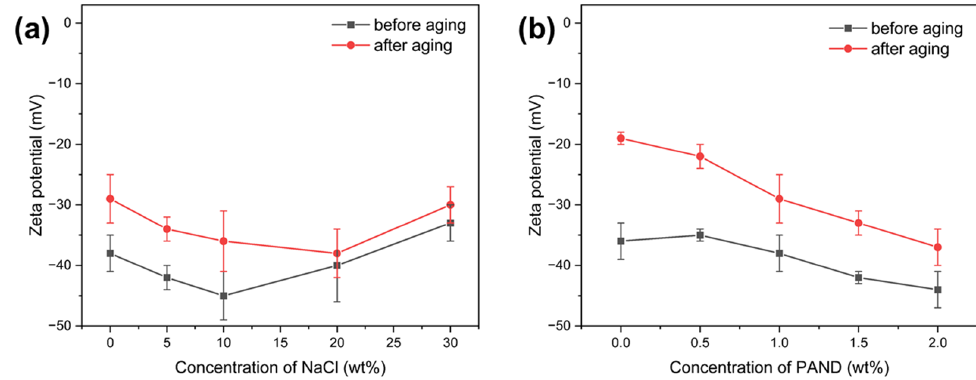
Figure 7. ( a ) Zeta potential curves of 4% bentonite WDF with different contents of PAND before and after aging. ( b ) Zeta potential curves of 1 wt% PAND drilling fluids with different fractions of NaCl before and after aging. The aging temperature is 180 °C.